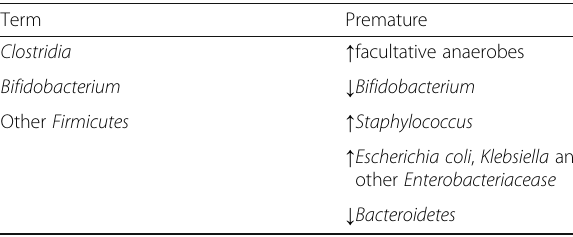
Table 2 Comparison of the Microbiome of Term and Premature